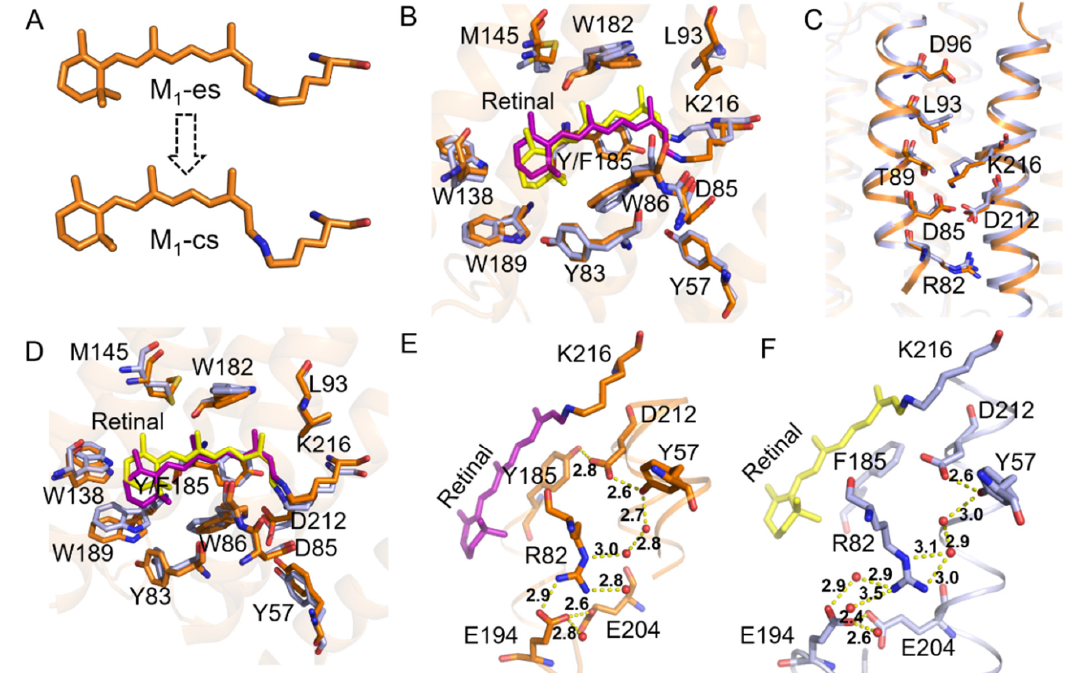
Figure 5. Conformation changes caused by the Y185F mutation in M 1 and M 2 states. ( A ) Schematic diagram of the two stages in M 1 state. ( B , C ) Superimposed drawing of the retinal binding pocket residues and the residues within the proton translocation channel in the WT-M 1 -es and Y185F-M 1 -es. ( D ) Superimposed drawing of the key residues in the retinal binding pocket in WT-M 1 -cs and Y185F-M 1 -cs. ( E , F ) Schematic diagrams of the H-bond network around the proton release groups in WT-M 2 and Y185F-M 2 , respectively. The color coding of 4B-F is the same as used in Figure 2E.